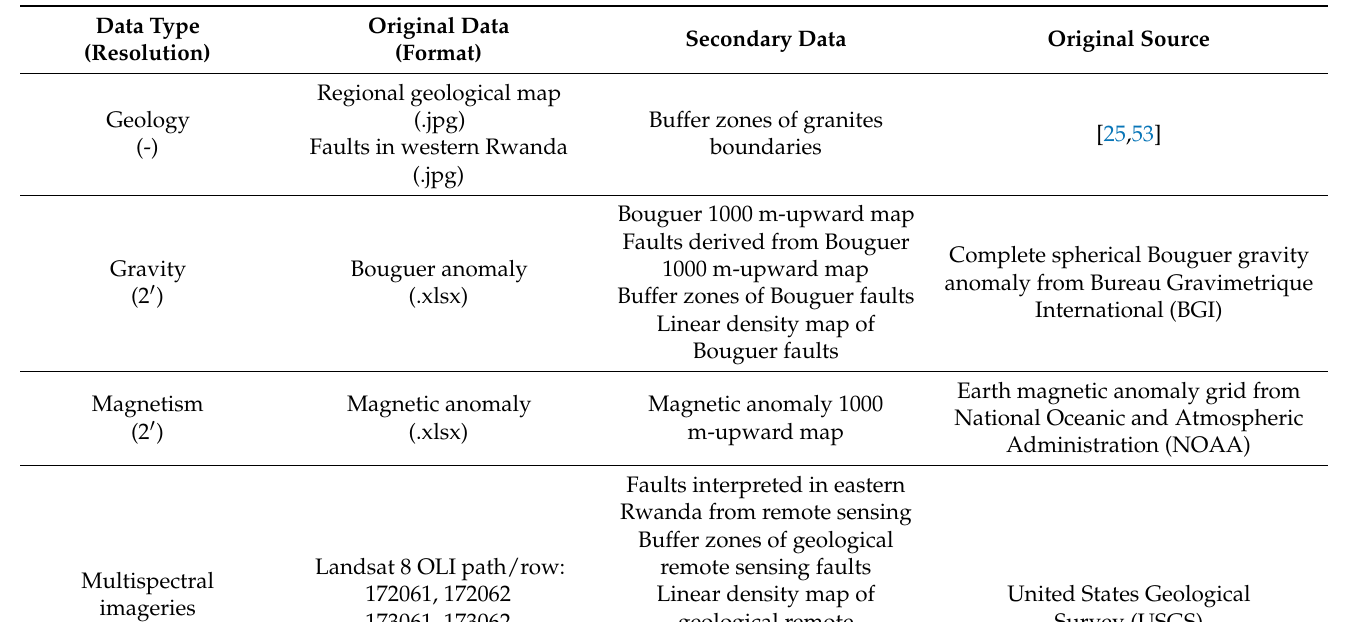
Table 1. List of